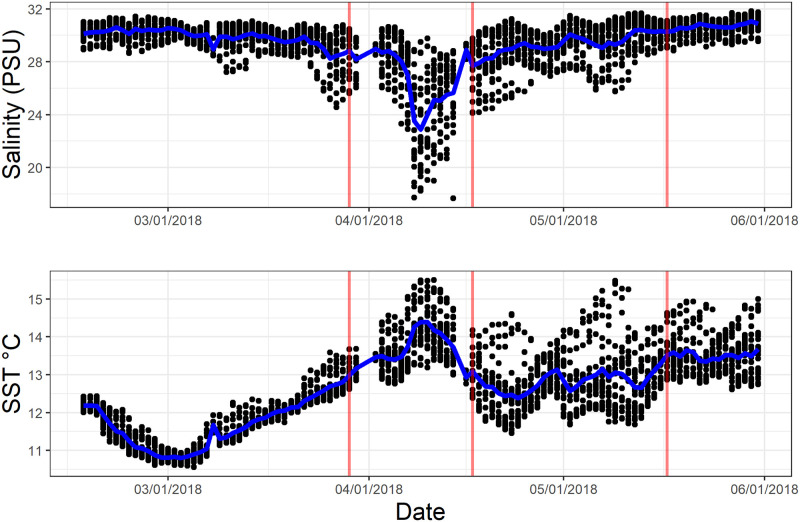
Salinity and temperature measurements at the Fort Point buoy during the survey period.Black dots show individual sampling measurements, the blue line shows daily average. Anemone sampling dates at Point Bonita are shown as red lines. One major freshwater outflow event occurred during the sampling period along with multiple minor events. Sea surface temperature (SST) was not as high as documented in past low salinity events. The most extreme low salinity period was roughly 10 days, longer than many outflow events in the past. Salinity at the Fort Point Buoy is measured and reported in PSU, equivalent to parts per thousand (ppt) reported in our experimental section.